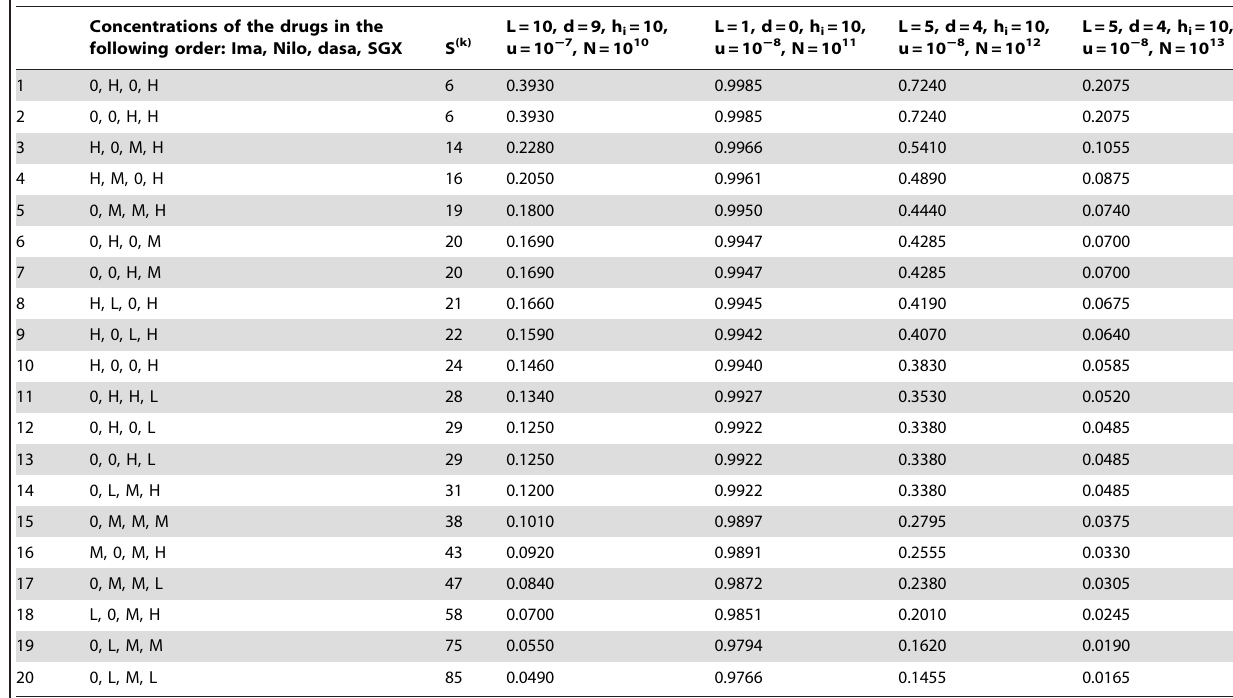
Table 7. Set ~ AA after all the steps of Algorithm A2. Details are as in table 5.